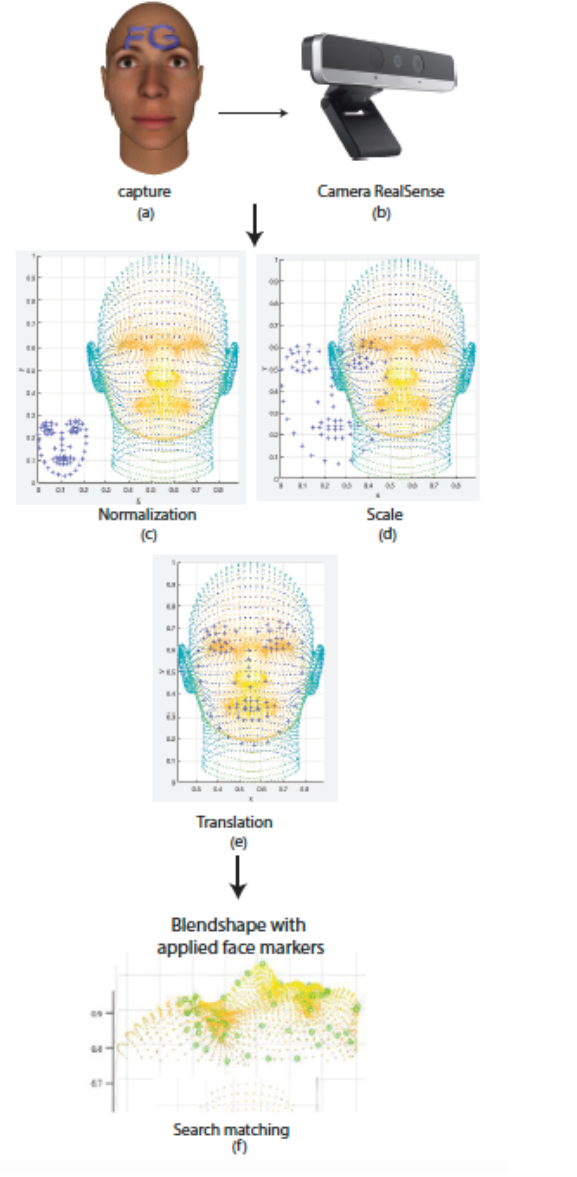
Fig. 3. Steps in generating blendshapes with facial marker associations. (a) 2D image; (b) RealSense camera detects the face and captures the points; (c) standardized model; (d) Adjusting the 2D points captured by the RealSense camera in the 3D model so that the scales between the models remain the same; (e) translocation of the scaled points using the reference point of the z-axis closest to the camera; (f) search for 3D points matches through the proximity of points.